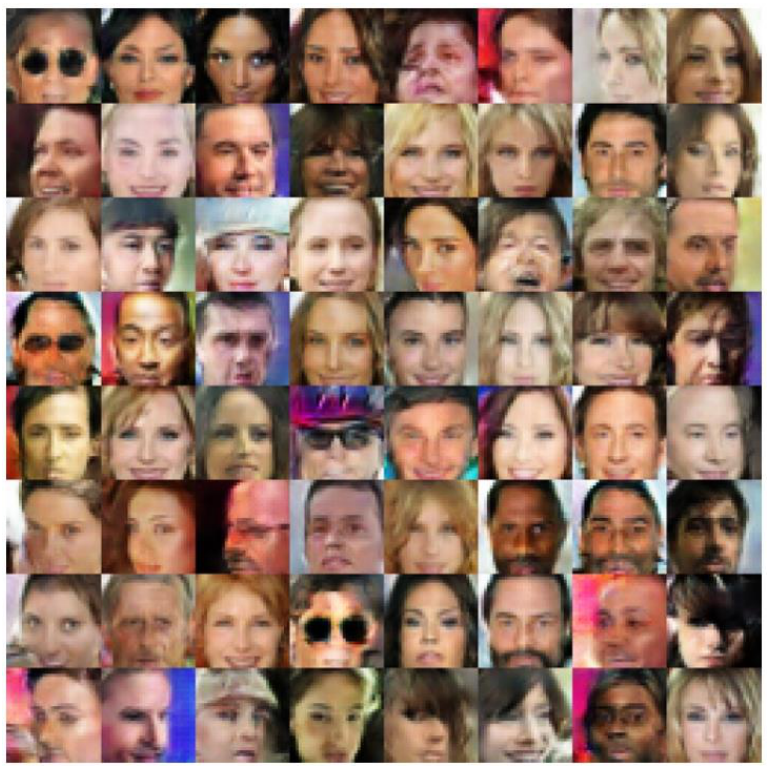
Figure 13. Representative images of VEEGAN (Variational Encoder Enhancement to Generative Adversarial Network) [44].